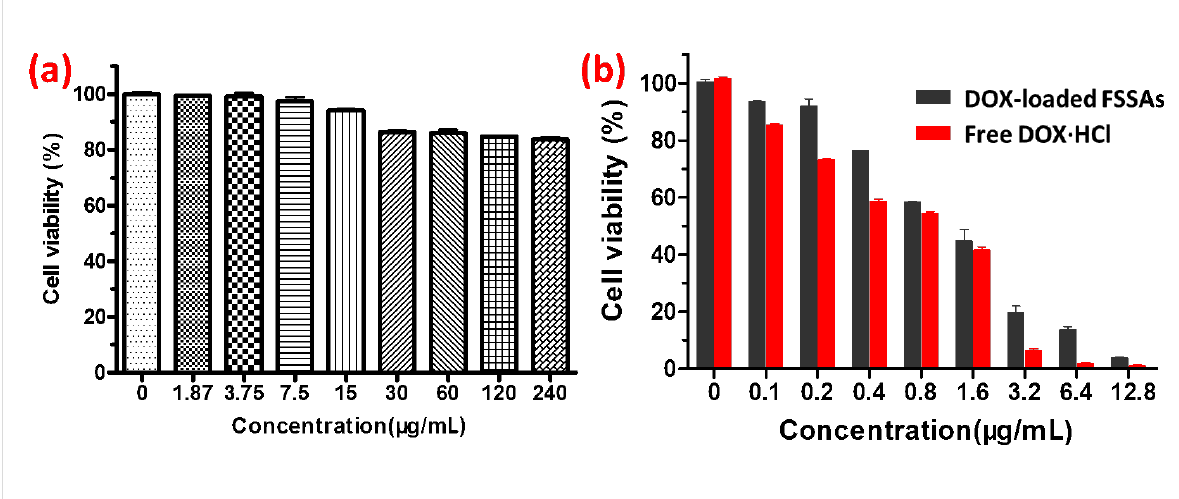
Figure 5: (a) Cell viability of PC-3 cells after incubated with β -CD-BM 2 based FSSAs for 48 h. (b) In vitro cytotoxicity of DOX-loaded β -CD-BM 2 based FSSAs and free DOX·HCl against PC-3 cells after incubation for 48 h.